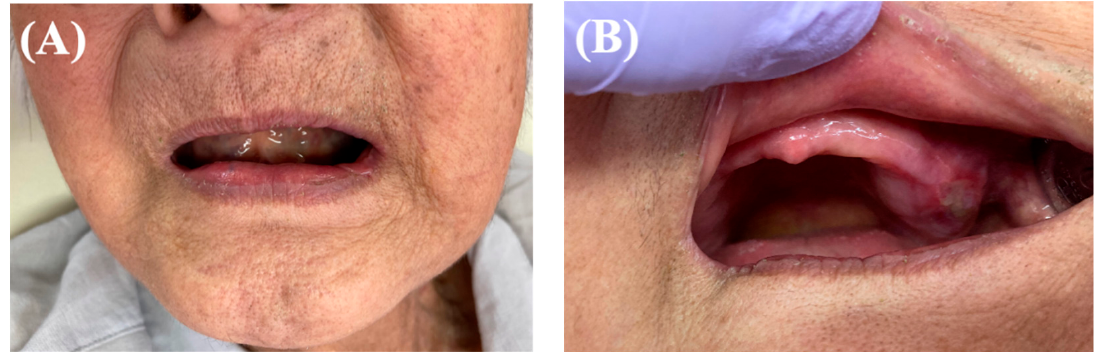
Figure 3. Oral and facial findings 30 days after discharge. ( A ) Blisters on the cheeks disappeared. ( B ) Ulcers in the oral cavity epithelialized and completely disappeared (denture ulcers remained).